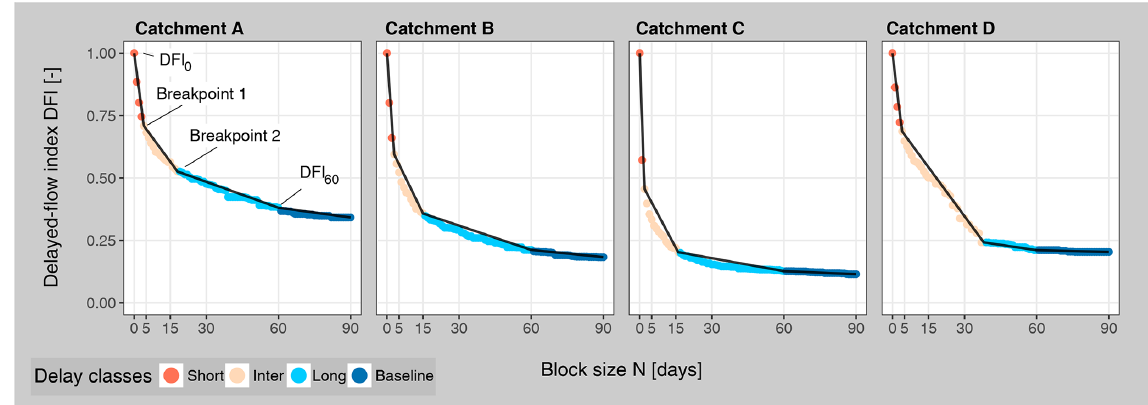
Figure 3. Various CDC curves for four example catchments A–D and their variation in DFI 0 , DFI 60 , and breakpoints 1 and 2. The example catchments are extracted from the study data set to highlight the variety of CDCs and ratios of delayed streamflow